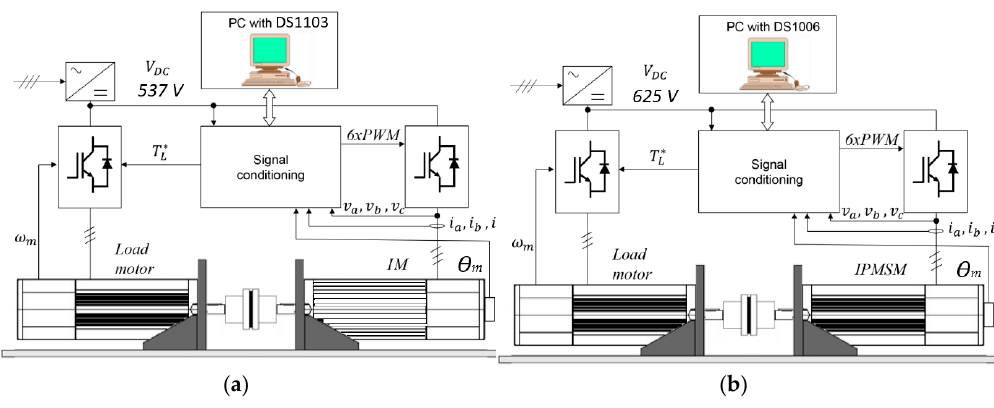
Figure 6. ( a ) IM tests bench and ( b ) PMSM tests bench.